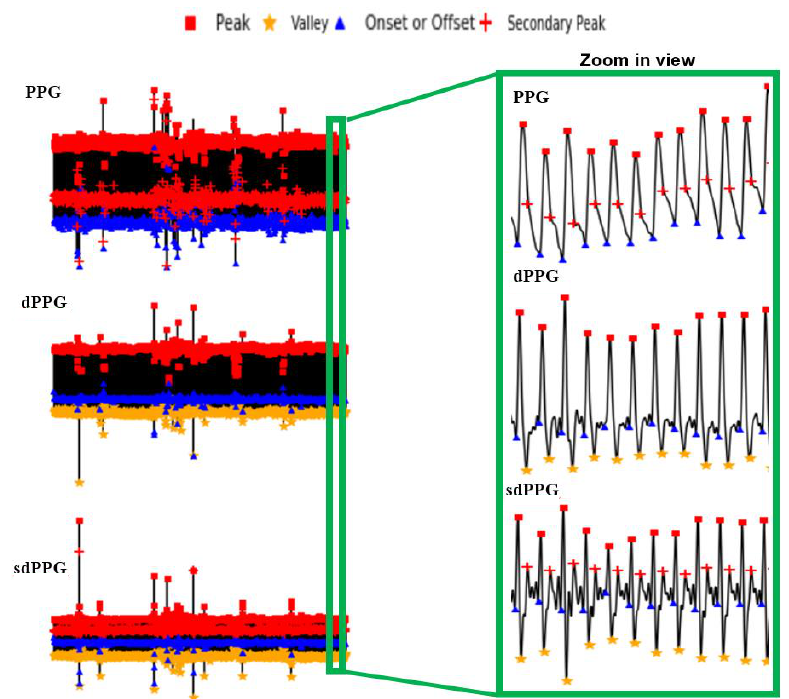
Figure 7. Examples of the results of feature point detection. Sensors 2020 , 20 , 5688